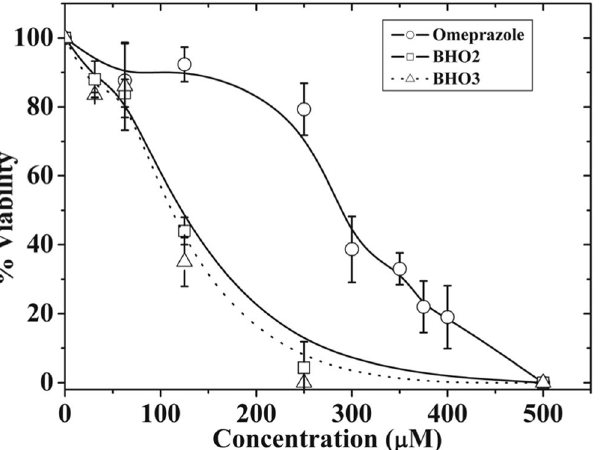
Figure 6. Anti-giardiasic activity of Compounds in trophozoites. Cultures of trophozoites (100,000 trophozoites/mL) were incubated during 48 hours at 37 °C with increasing concentrations of compounds. Afterward, samples were withdrawn and resuspended in a medium free of compounds. The samples were incubated for other 48 hours/37 °C and thereafter, the viability of trophozoites were quantified. The values represent ± standard deviation from three independent experiments.